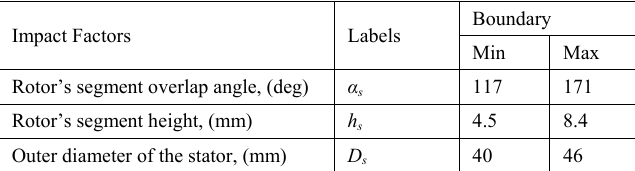
Fig. 3. Geometry of new design SynRM with segment-shaped outer rotor. I MPACT F ACTORS FOR N UMERICAL E